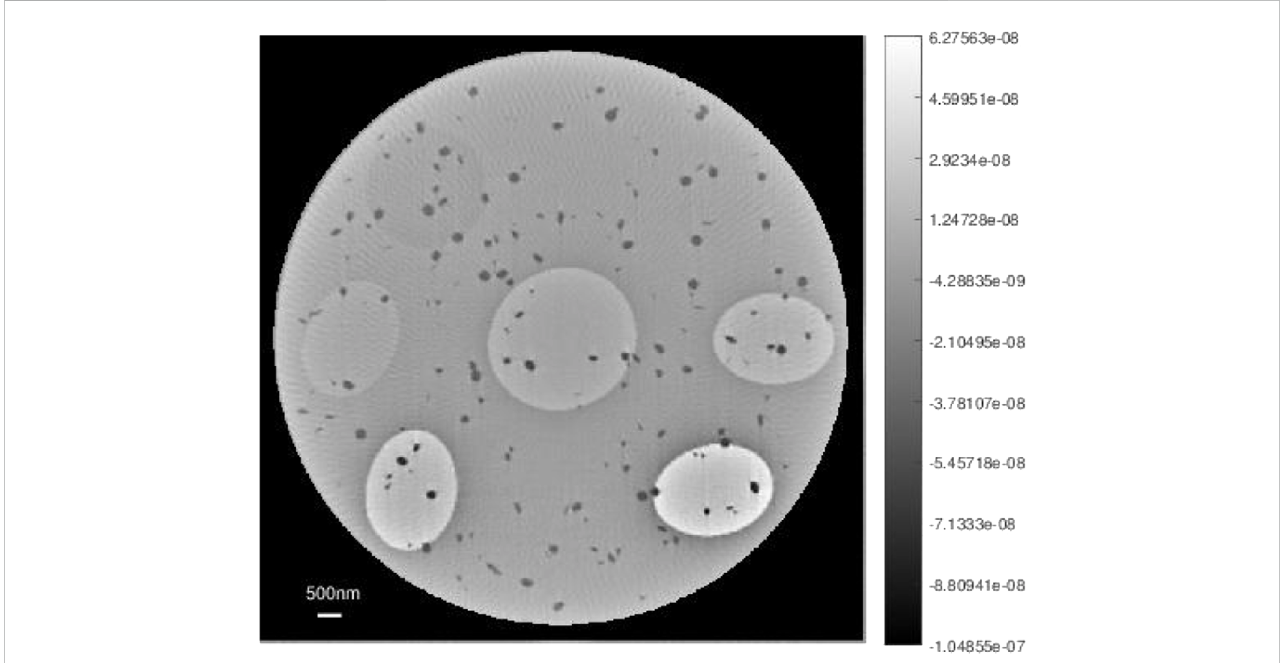
FIGURE 8 The inversion result using TFDM for noisy data with noise-level 0.1%.